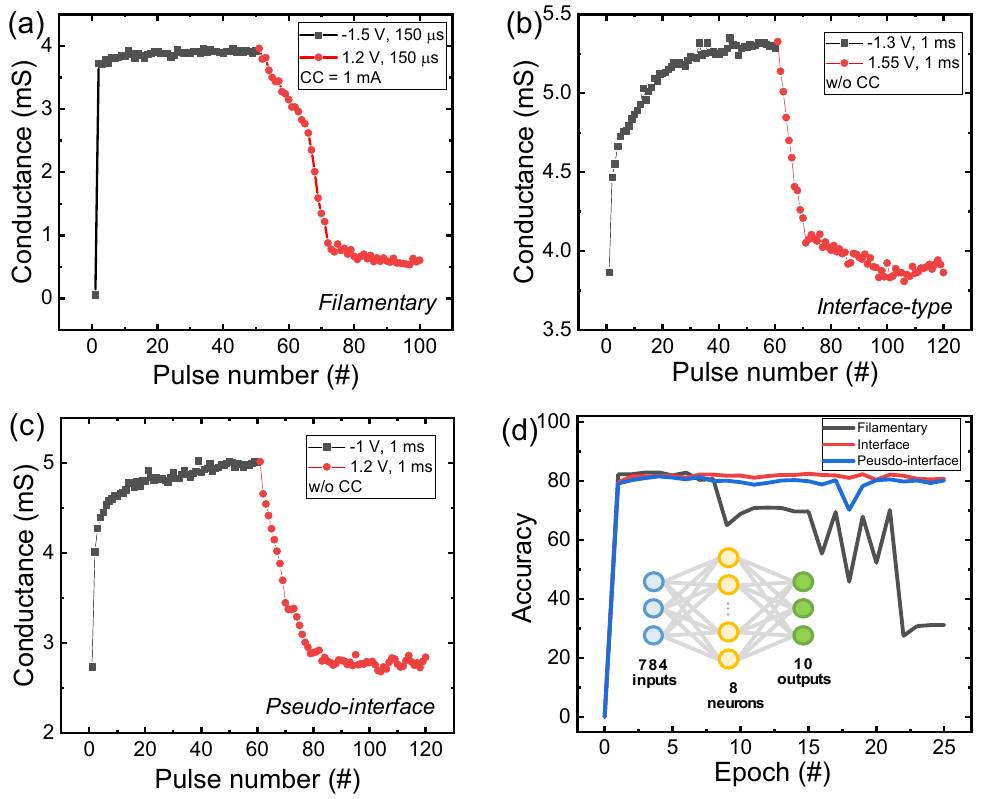
Figure 5. Synaptic properties of the TaO x / HfO 2 memristor: Potentiation and depression curves: ( a ) filamentary; ( b ) interface-type; and ( c ) pseudo-interface-type switching. ( d ) Pattern recognition accuracy test for classification of images of clothing taken from the Fashion Modified National Institute of Standards and Technology (MNIST) dataset by applying the conductance of the three types of switching in the neural